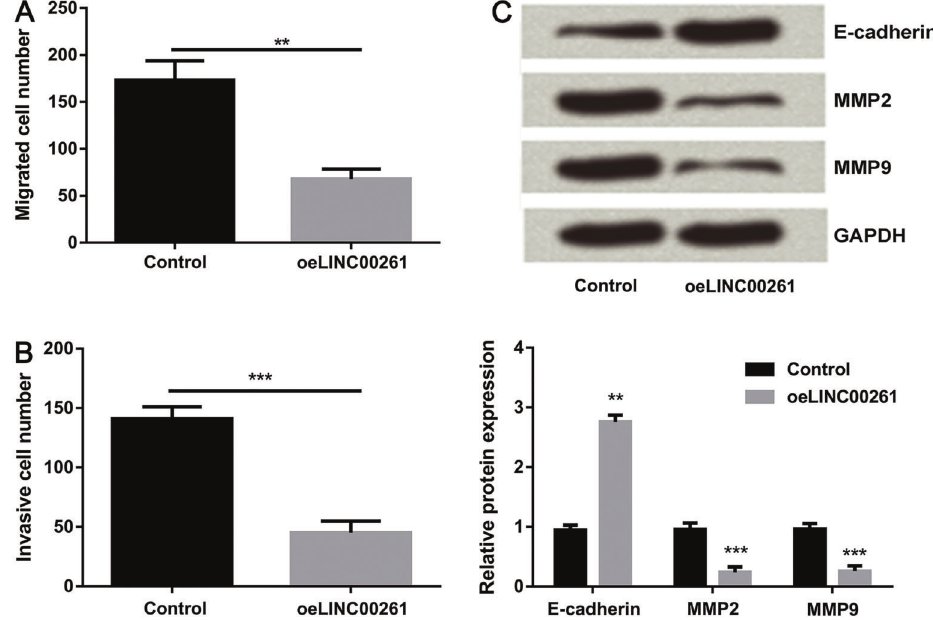
Figure 5. Effects of LINC00261 overexpression on cell migration and invasion. A and B , overexpression of LINC00261 inhibited colon cancer cell migration and invasion. C , Expression of colon cancer cell migration and invasion-related proteins. Oe: overexpression. Data are reported as means ± SD. **P o 0.01; ***P o 0.001